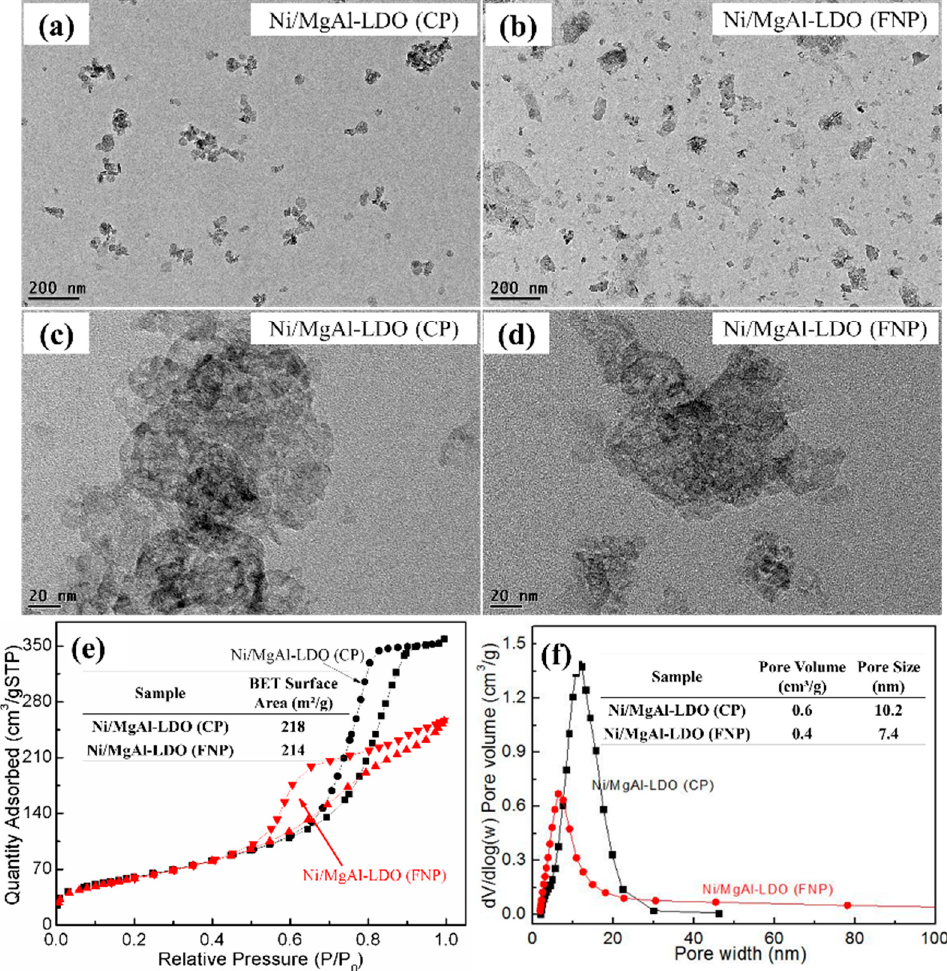
Figure 7. TEM and HRTEM images of ( a , c ) Ni/MgAl-LDO (CP), ( b , d ) Ni/MgAl-LDO (FNP). ( e ) N 2 adsorption-desorption isotherm for Ni/MgAl-LDO (CP) and Ni/MgAl-LDO (FNP). ( f ) Pore size distribution of Ni/MgAl-LDO (CP) and Ni/MgAl-LDO (FNP). Table 2. Elemental analysis of Ni, Mg, Al, and O elements content by X-ray photoelectron spectroscopy (XPS).